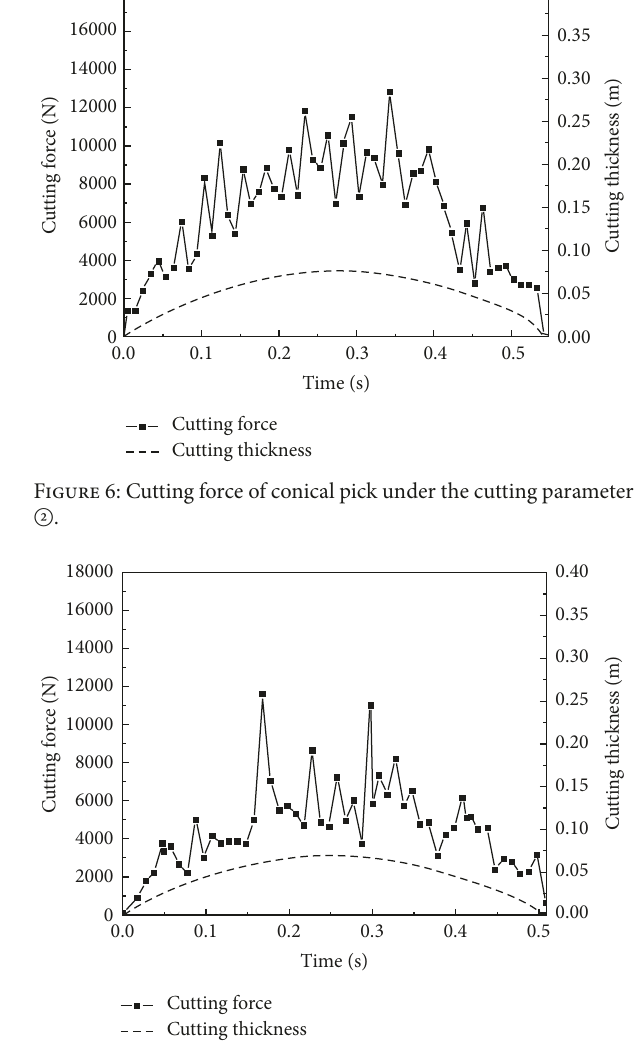
Figure 7: Cutting force of conical pick under the cutting parameter C